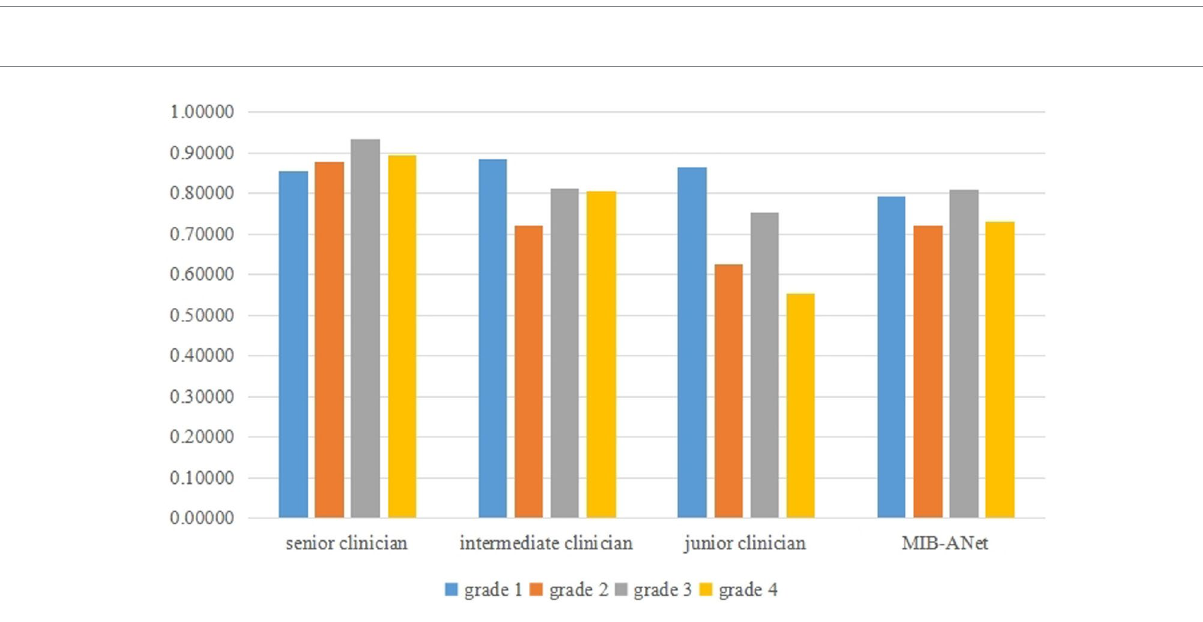
FIGURE 6 The F1 score of different grades for MIB-ANet, senior clinician, intermediate clinician, and junior